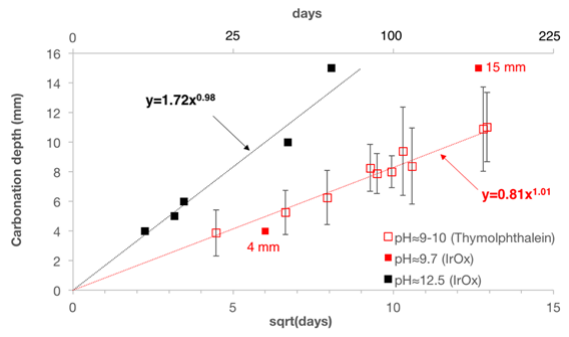
Figure 6. Carbonation depth at pH ≈ 12.5 and pH ≈ 9.7(obtained with the embedded IrO x sensors) and at pH 9 ‐ 10 (average of the individual measurements of the thymolphthalein spraying test, together with the standard deviation, indicated with the error bars) as a function of the square root of time in the carbonation chamber. The linear regression curves for the carbonation front at pH ≈ 12.5 and at pH ≈ 9 ‐ 10 (obtained with the pH indicator) are indicated with dotted